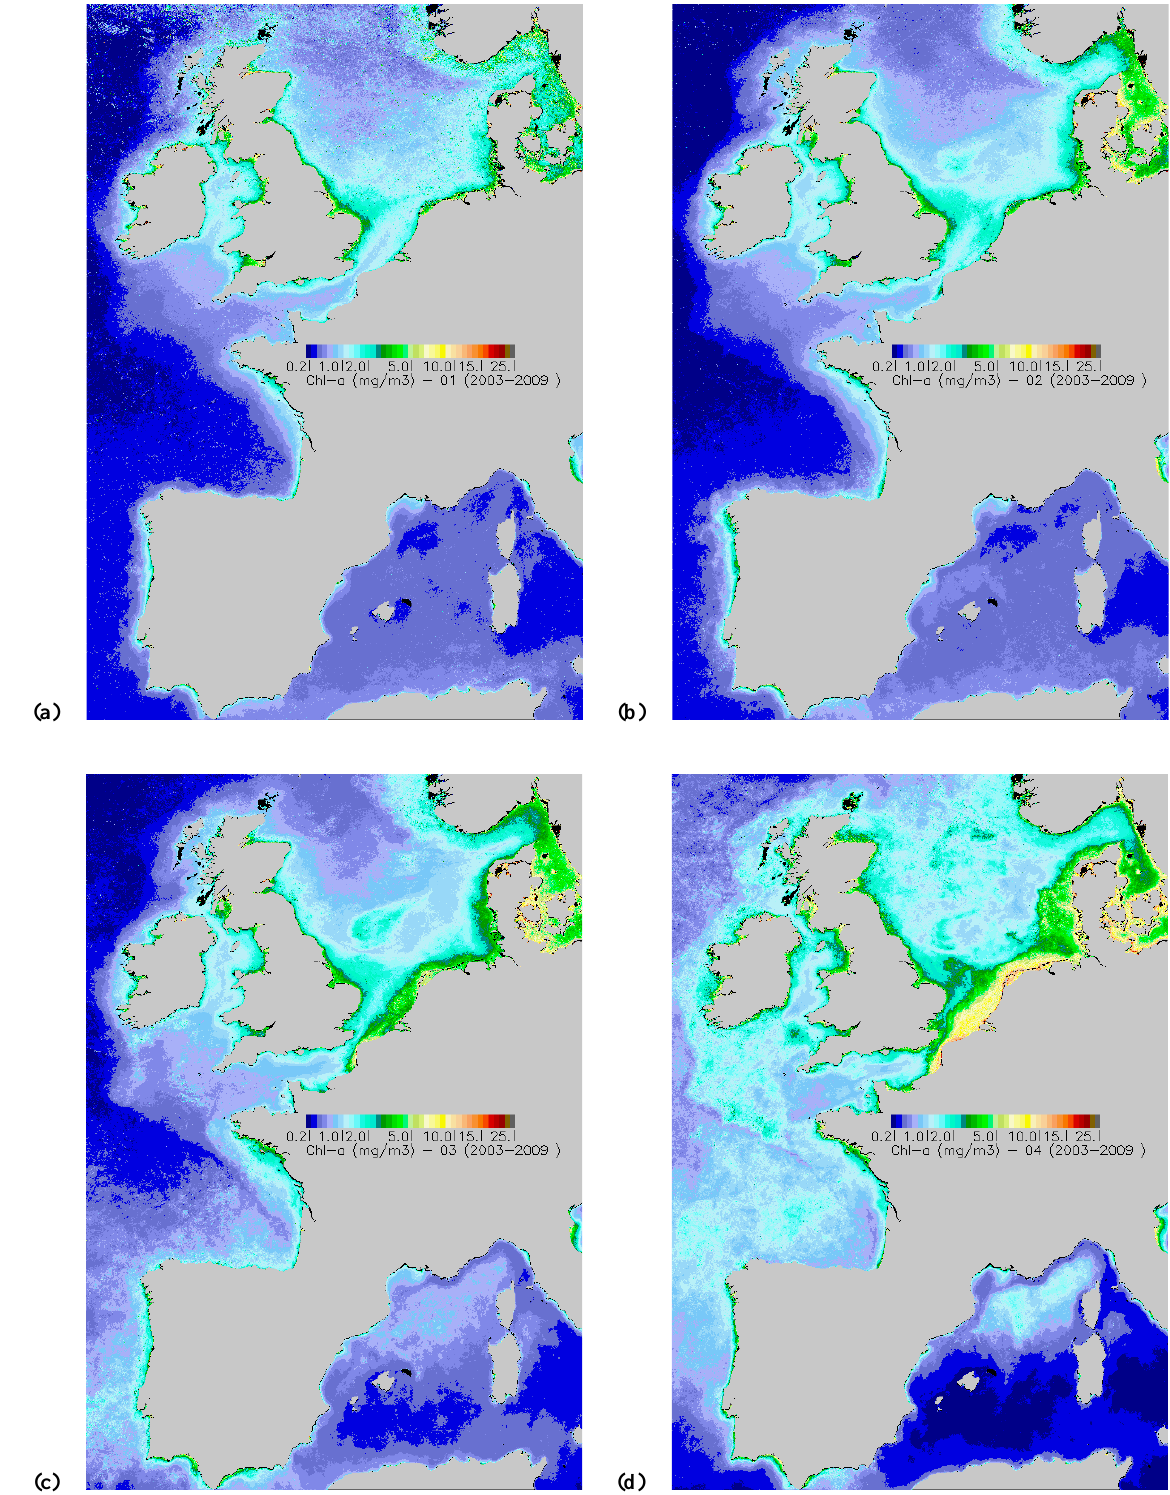
Fig. A1. Monthly chlorophyll- a concentration in January (a) , February (b) , March (c) and April (d) .